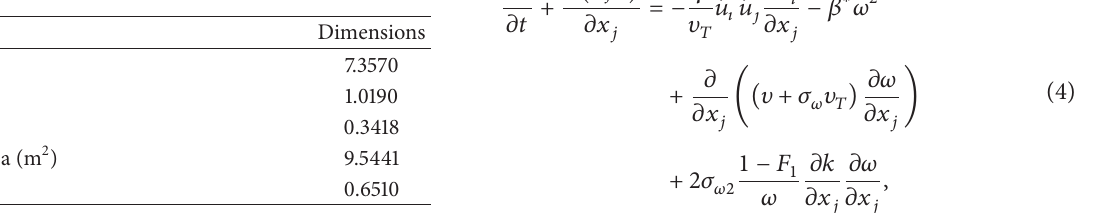
Table 1: Main characteristics of ship